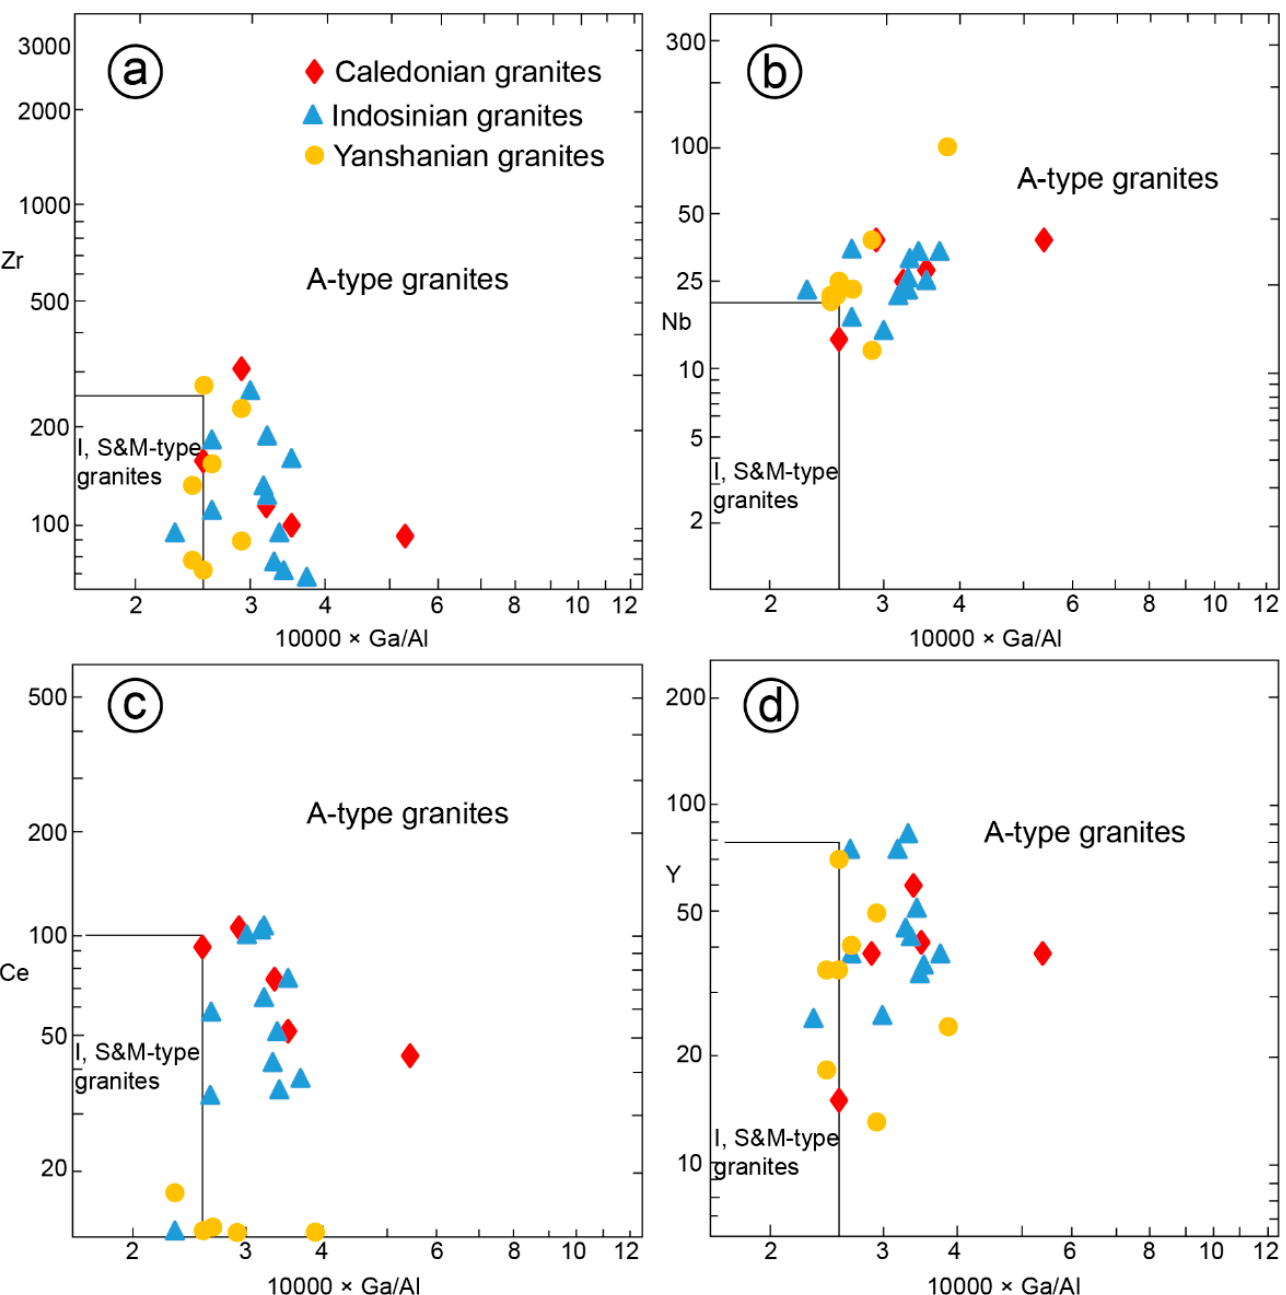
Figure 17. 10,000 × Ga/Al versus Zr ( a ), Nb ( b ), Ce ( c ) and Y ( d ) plots of various granites from the Taoxi dome. Diagrams are from Whalen et al. (1987) [44].